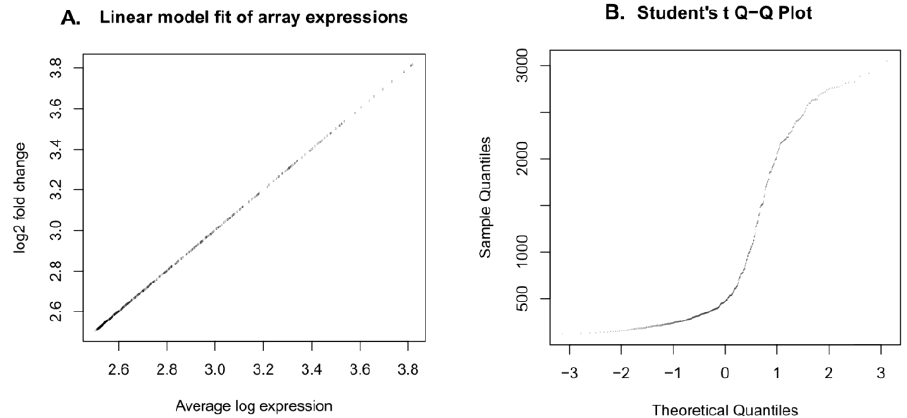
Figure 4. Linear fitting and statistical testing of normalized miRNA expression data. Linearmodel fitting performed for all ofthe GBM miRNA arrays with the same probes used in this analysis. ( A ) Correlation between observed log2 fold expressions plotted against average expression in y and x axes, respectively. ( B ) Students Quantile–Quantile plot showing the quantiles of data sample against the theoretical quantiles of student’s t distribution calculated for the sample.